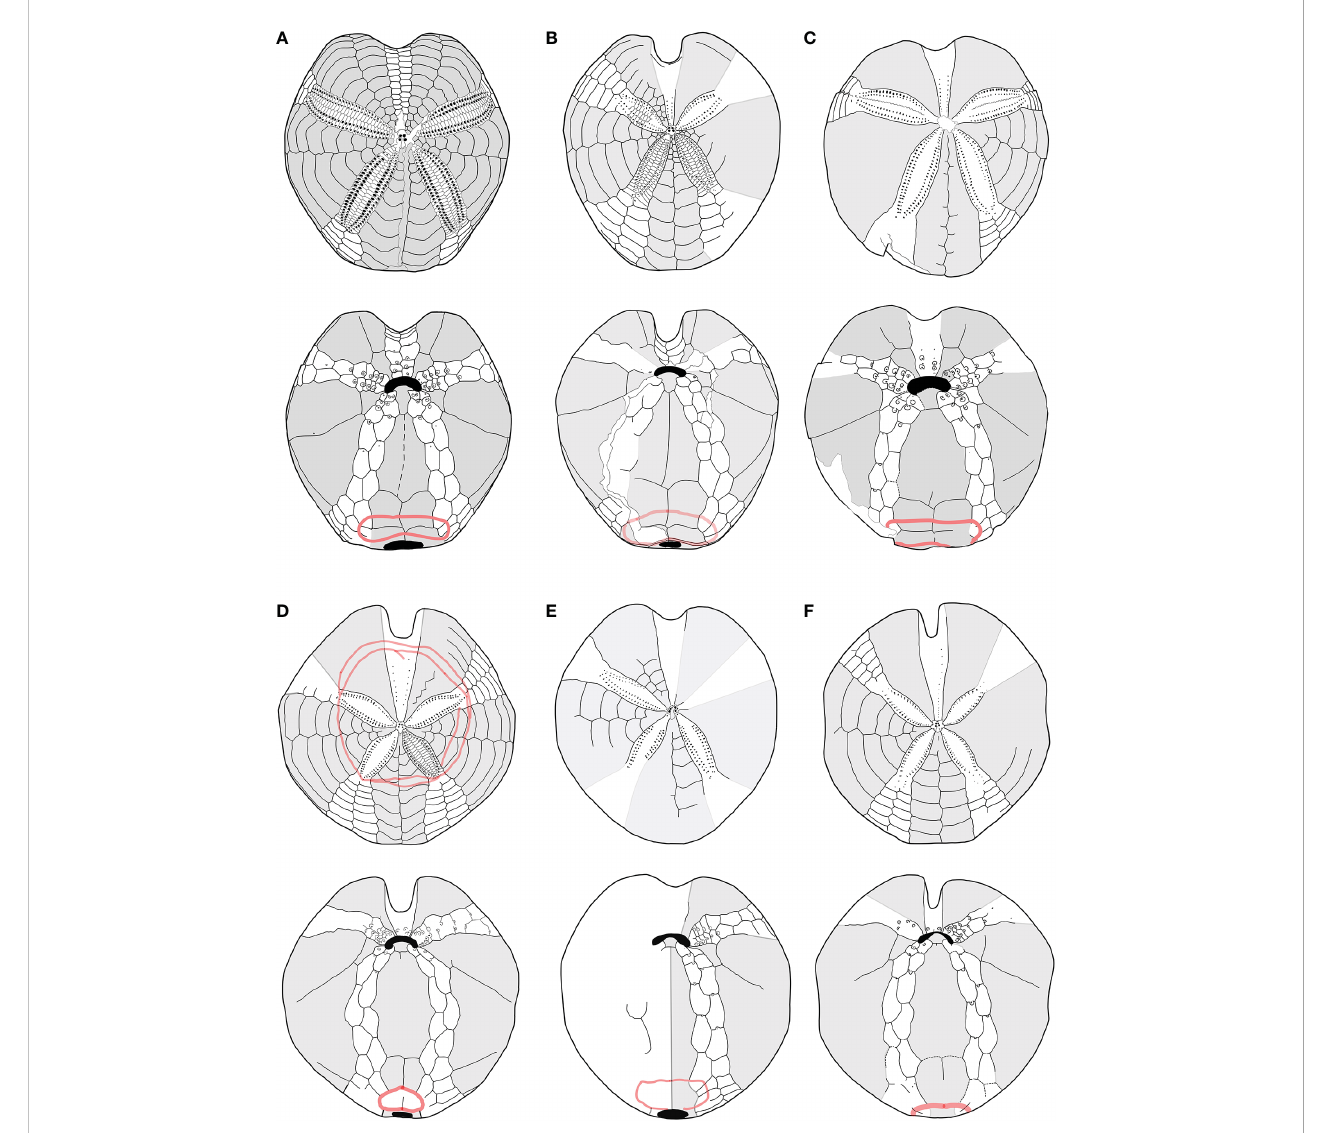
FIGURE 6 (A – F) Structural similarities in aboral (up) oral and oral (down) schemes, between fossil and recent species of Spatangidae analyzed in this work. (A) Sardospatangus caschilii , Miocene, Burdigalian of Isili, Sardinia, Italy (MAC PL 344); (B) Sardospatangus saheliensis , Messinian-Pliocene of Melilla, Spain, North African coasts (MNHN no. R62132); (C) Spatangus desmaresti , Oligocene, Chattian of Doberg, Westphalia, Germany (MHNG no. 127-27828); (D) Plethotaenia angularis , Recent, Caribbean Sea (Redrawn from Schultz, 2009, in Kroh and Mooi, 2022; (E) Spatangus californicus , Baia California, Mexico (Redrawn from Mortensen, 1951); (F) Spatangus mathesoni , New Zealand, Station D0231 (NIWA paratype